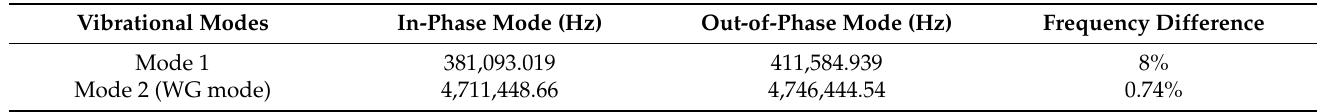
Table 6. Differences in resonant frequencies of a 2-DoF mechanically coupled BAW square resonator system operated at different vibrational modes obtained by FEM simulation in